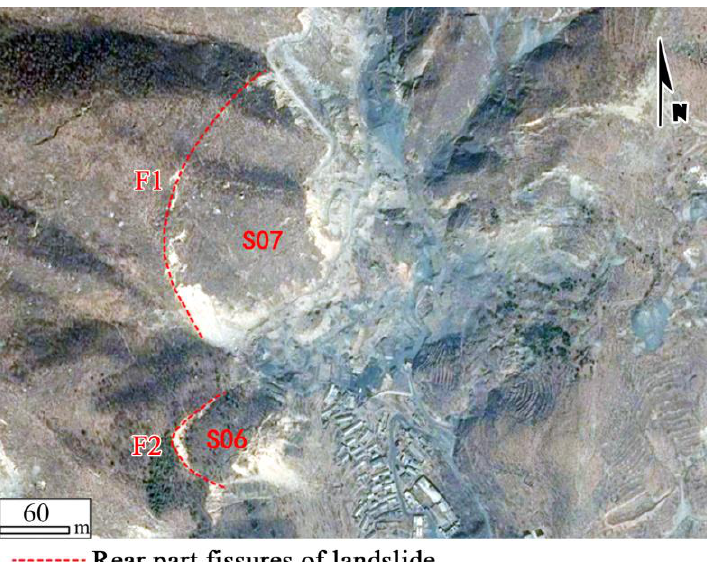
Figure 15. Optical image of landslides S06 and S07 in 2012.